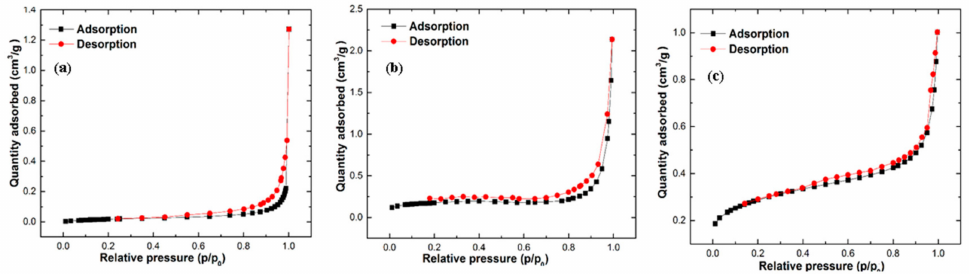
Figure 5. Water vapor adsorption and desorption profiles at 298 K: ( a ) pristine GO, ( b ) GO–Al composite, and the ( c ) GO–CTS composite.